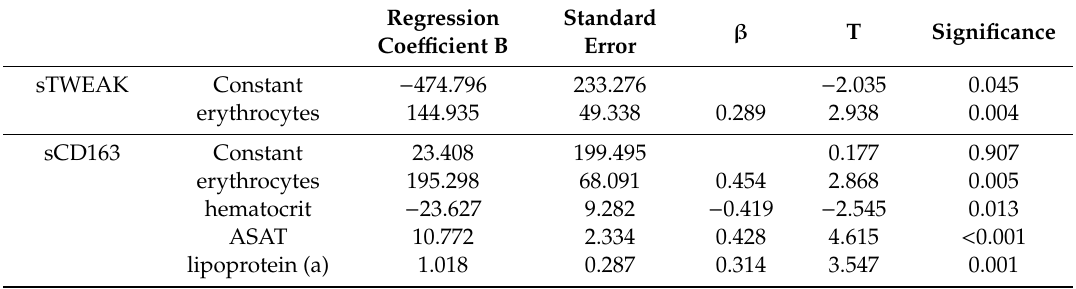
Table 2. Linear regression model with backwards method: All significant correlations of the Spearman test, as shown in Table S1, were included in a linear regression model with backwards method.